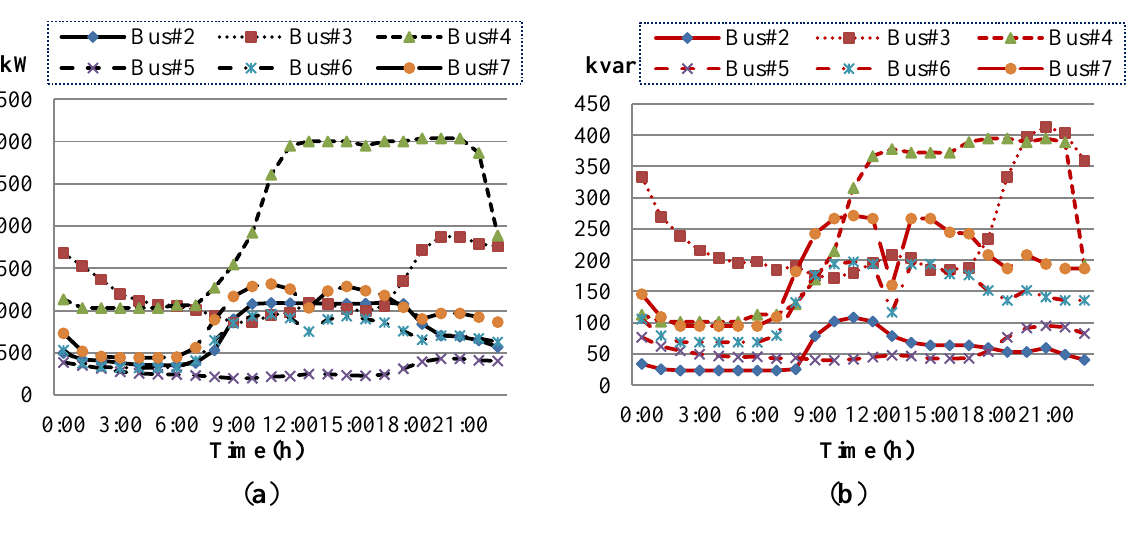
Figure 8. Equivalent lump-load demand curve at each bus: ( a ) real power; and ( b ) reactive